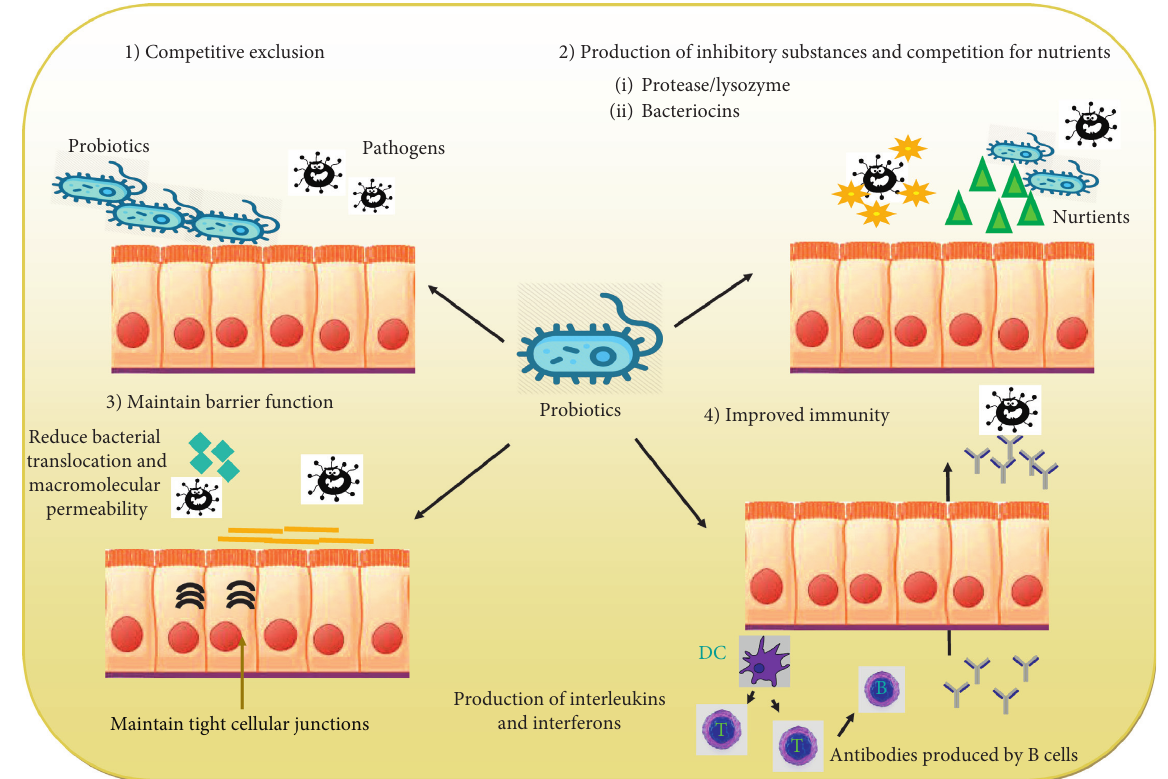
Figure 1: Role of probiotics in the amelioration of gut functions. (1) The probiotics could protect from pathogenic microbes in a diversified manner. (2) The probiotics can secrete the antimicrobial compounds and metabolites such as lactic acid, enzymes, and bacteriocins which can alter the pH that ultimately can inhibit the growth of pathogens. (3) The probiotics maintain the gut mucosal barriers, i.e., the chemical barriers such as antimicrobial peptides (AMPs), which can inhibit the invading microorganisms, and the physical barriers including cellular junction and the mucus layer that repel the invading microorganisms. (4) The alliance of microbiota with the immune system allows the maintenance of regulatory function involved in the conservation of tolerance to safer antigens and induction of protection to the